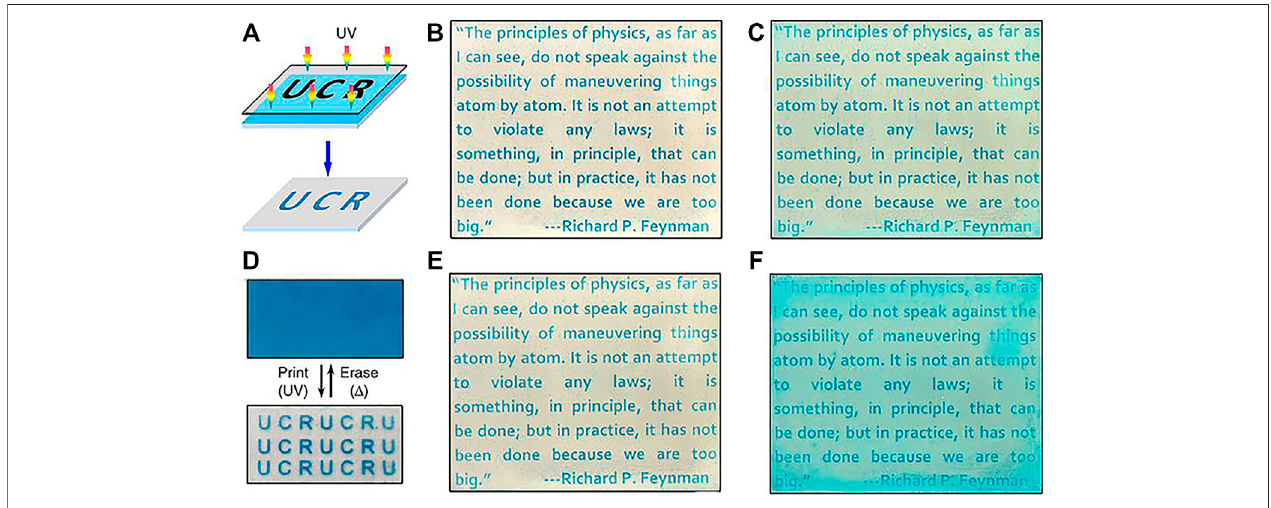
FIGURE 13 | Printing, erasing, and legibility of letters on the rewritable paper. (A) Schematic representation of writing letters on the rewritable paper using photomask on UV light irradiation; (B) digital images of writing and erasing letters on the rewritable paper; Digital images of rewritable paper maintaining in ambient air after writing of (C) 10 min, (D) 1 day, (E) 3 days and (F) 5 days. Scale bars, 5 mm. The photomask was produced by ink-jet printing on plastic transparency. The slight variationinthebackgroundwasduetotheuneven thickness ofthe fi lmresultingfromthemanualdrop-casting.Reprinted withpermissionfromWang et al.(2014). Copyright © 2014 Springer